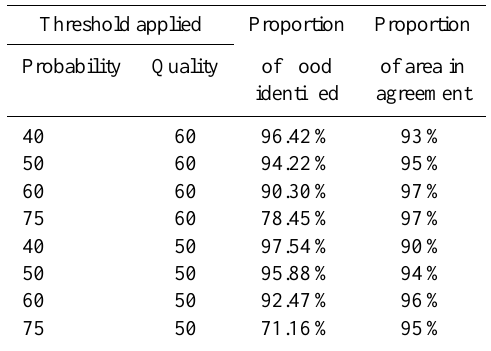
Figure 7. Results of the GFO water probabilities over the Chao Phraya basin on 13 October 2011 as shown in Google Earth (left panel). HAND values with flooded areas (light blue) are shown on the right panel.